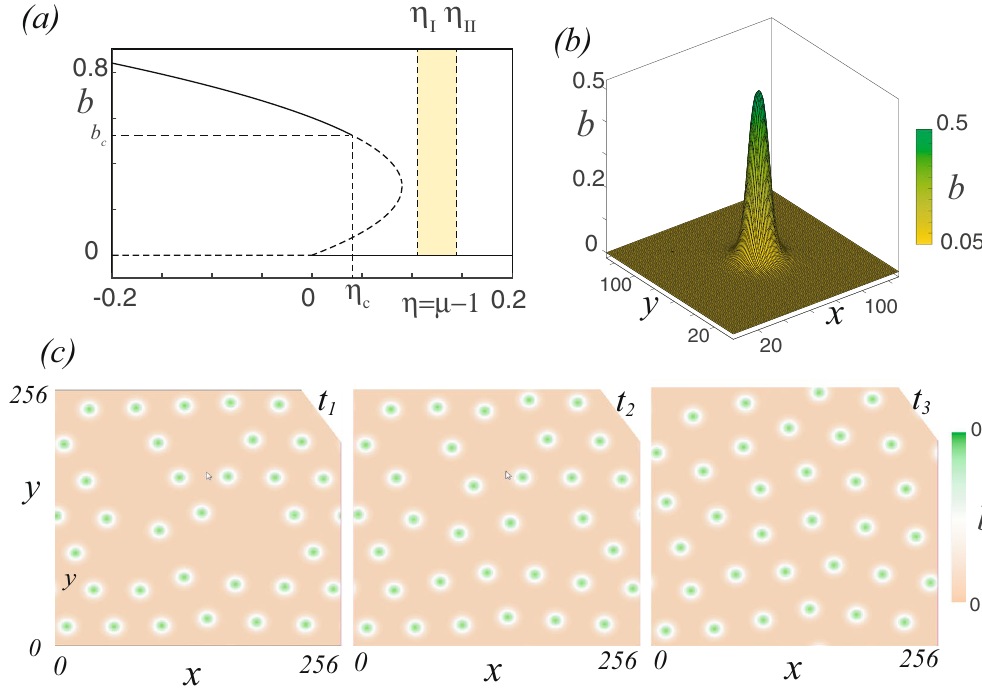
Figure 2. Localised vegetation patches in model Eq. (1). ( a ) Typical bifurcation diagram ( χ f > 1 + χ c ), biomass b as function of effective aridity η = μ − 1. η c stands for to the spatial instability threshold. η I and η II delimit the region where localised vegetation patches are observed. ( b ) Localised vegetation patch obtained from numerical simulation of model Eq. (1) for μ = 1.04, χ f = 2, χ c = 1, D = 1, σ Φ = σ − e r ( ) / ( c ) Temporal evolution of localised vegetation patches ( t 1 < t 2 < t 3 ), from a random initial distribution of localised vegetation